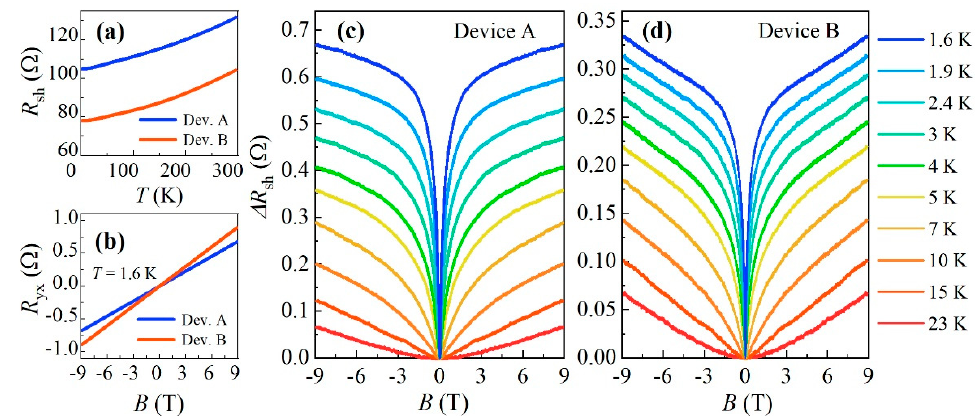
Figure 3. ( a ) Temperature dependence of sheet resistance. ( b ) Hall resistance measured at T = 1.6 K. ( c , d ) Magnetoresistance ∆ R sh ( B ) = R sh ( B ) − R sh ( 0 ) measured at various temperatures between 𝑇 = 1.6 K and 23 K.